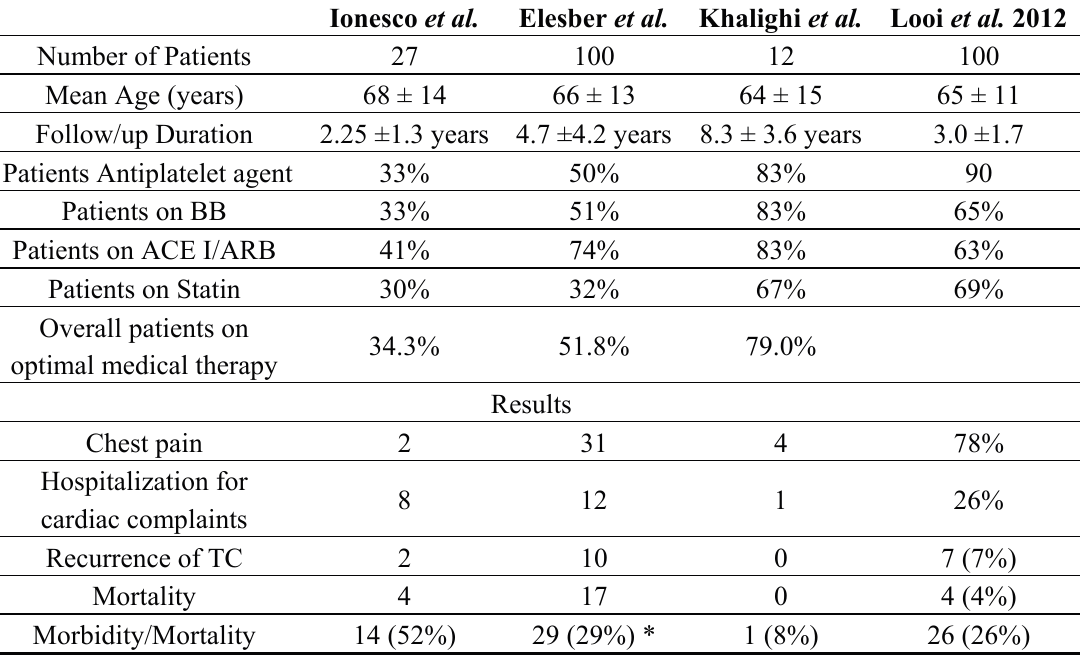
Table 6. Comparing the Data from Previous Studies. Ionesco et al. Elesber et al. Khalighi et